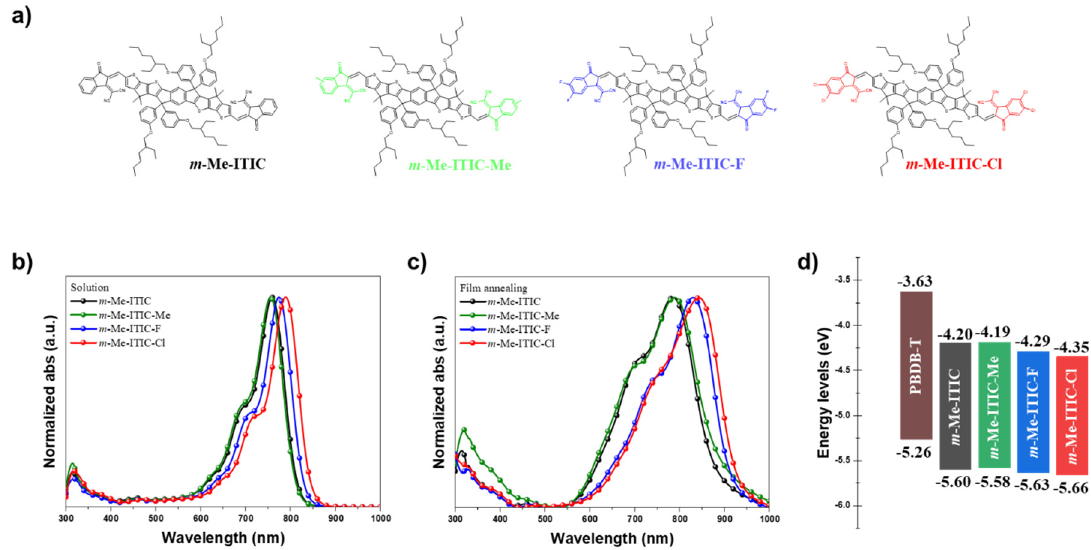
Table 1. Optical and Electrochemical Properties of acceptors.